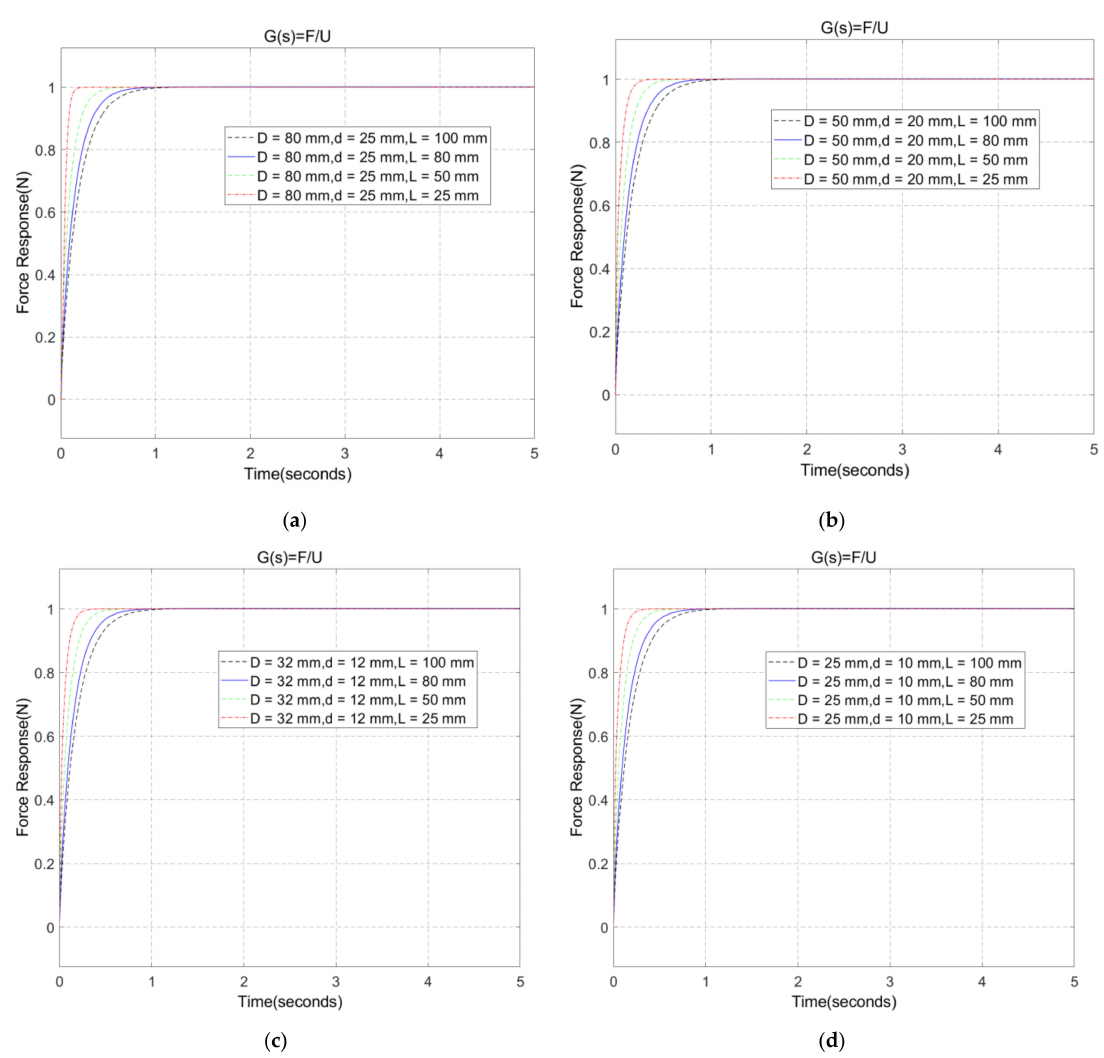
Figure 16. Force response curves with the same cylinder diameter and different strokes. ( a ) D = 80 mm, Kp = 1 × 10 − 4 , Ki = 1 × 10 − 6 , Kd = 1 × 10 − 6 ; ( b ) D = 50 mm, Kp = 1 × 10 − 4 , Ki = 1 × 10 − 6 , Kd = 1 × 10 − 6 ; ( c ) D = 32 mm, Kp = 1 × 10 − 4 , Ki = 1 × 10 − 6 , Kd = 1 × 10 − 6 ; ( d ) D = 25 mm, Kp = 1 × 10 − 4 , Ki = 1 × 10 − 6 , Kd = 1 × 10 − 6